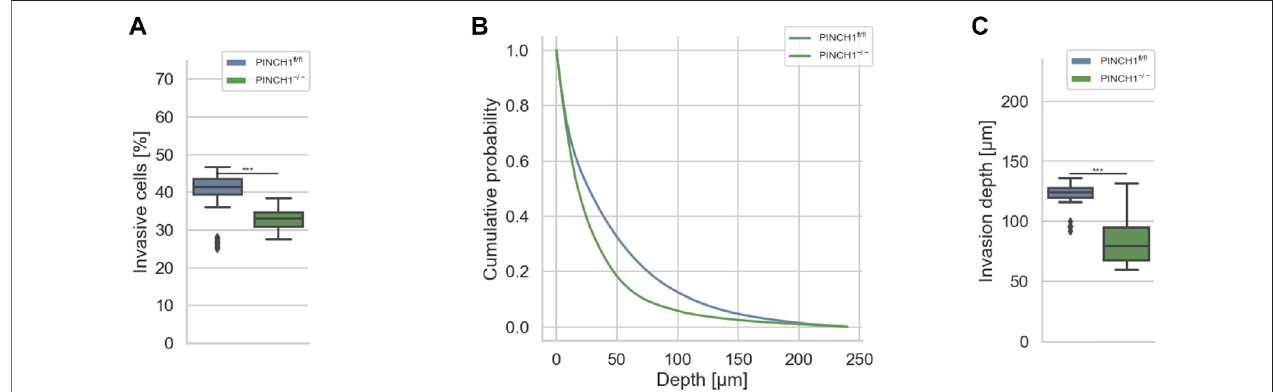
FIGURE 1 | 3D collagen invasion of PINCH1 − / − and PINCH1 fl / fl cells. (A) Average percentage of invasive migrating PINCH1 − / − cells ( n = 813,241 total number of cells) is pronouncedly decreased compared to PINCH1 fl / fl cells ( n = 1,336,561 total number of cells). (B) Invasion depth pro fi les of the invasive PINCH1 − / − cells (green) and invasive PINCH1 fl / fl cells(blue)thatmigratedinthe3D extracellular matrices after threedays ofculture at37 ° C,95%humidityand 5%CO 2 . (C) Theaverageinvasion depths of PINCH1 − / − cells (green column) is pronouncedly lower compared to PINCH1 fl / fl cells (blue column). (A,C) data are presented as box and whiskers plots (Q2 represent mean values). (*** p < 0.001; Kruskal-Wallis